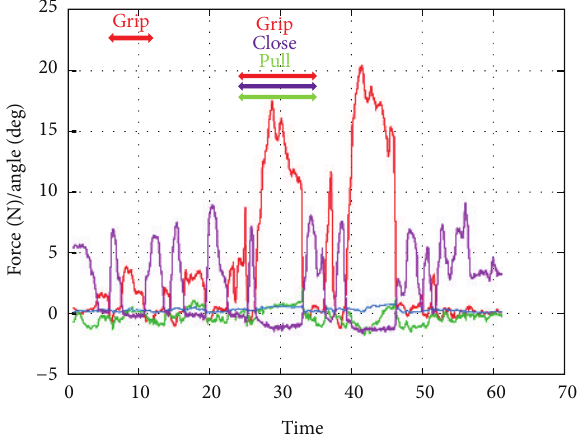
Figure 10: Experiment (E), grip and pull the